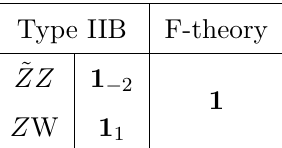
Table 14 . On the left column, the states in type IIB with the charges under the massive U(1). On the right column the F-theory state (charged under the discrete Z 3